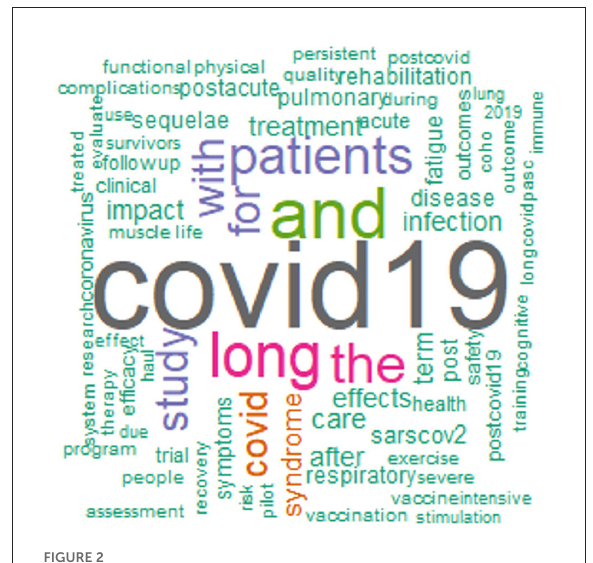
FIGURE2 Wordcloud of titles of all the long-COVID-19